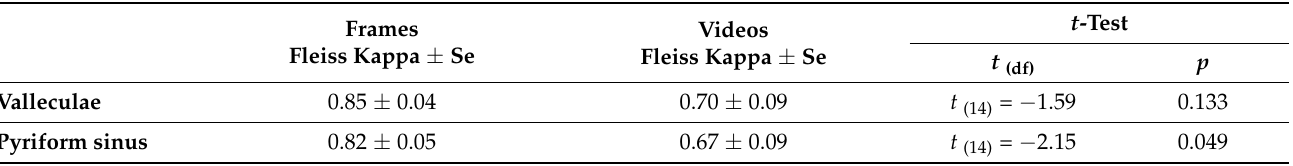
Table 5. Inter-rater reliability in frames and videos across all raters (n = 29) for all consistencies